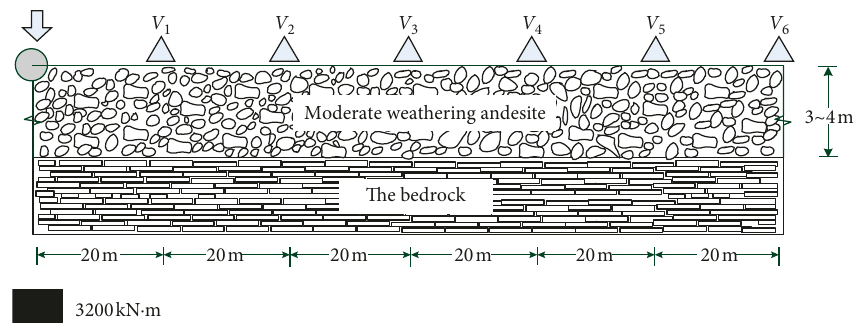
Figure 2: Arrangement of dynamic compaction velocity sensors (unit: m).